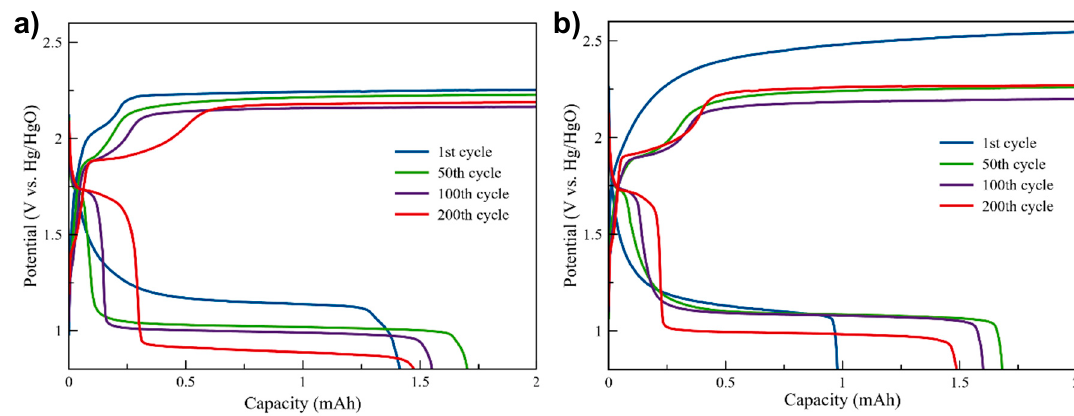
Figure 10. Charge and discharge performances of the ZAB under 10 mA / cm 2 in electrolyte solution at the 1st, 50th, 100th and 200th cycle for ( a ) Zn / IF and ( b ) Zn / NF electrodes.